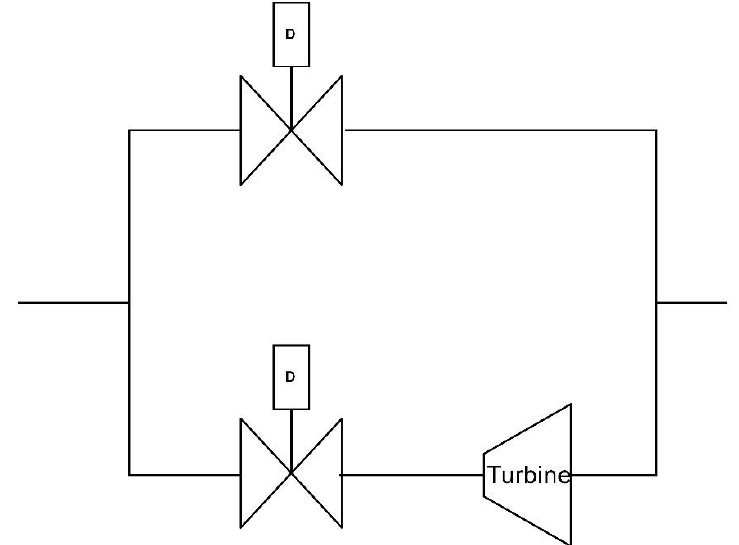
Figure 9. Schematic representation of turbine planting in a water supply network.